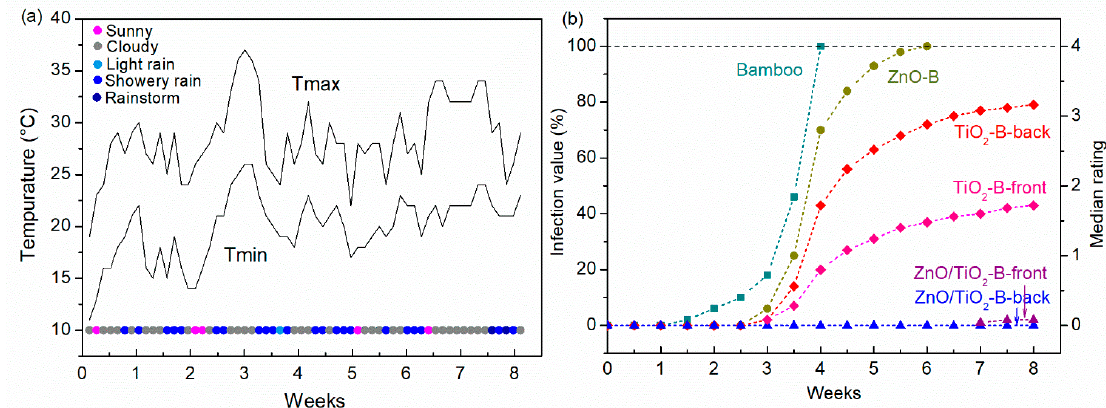
Figure 4. ( a ) The temperature and weather at test site from 24 April to 24 June; and ( b ) Median value of fungal growth on pristine bamboo, ZnO-B, TiO 2 -B and ZnO/TiO 2 -B.